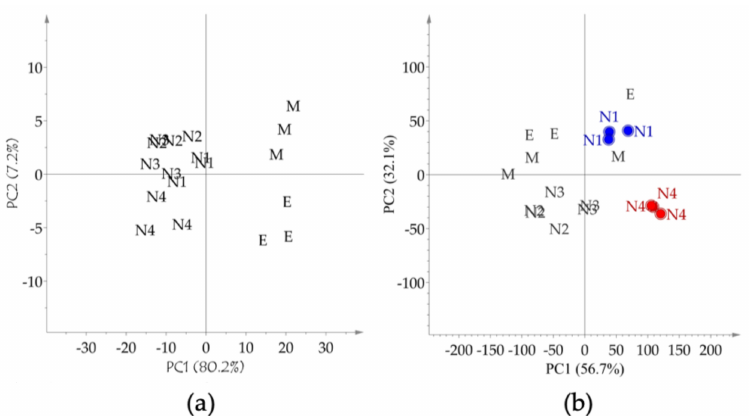
Figure 3. Score plot of principle component analysis of the HPTLC ( a ) and HPLC ( b ) data obtained from the extracts of 80% aqueous methanol, 70% aqueous ethanol, and natural deep eutectic solvent (NADES) extracts of Scutellaria baicalensis bark. M: 80% methanol in water extract ( v / v ), E: 70% ethanol in water ( v / v ), N1–N4: NADES with the addition of 10% water ( w / w ). N1: citric acid– β -alanine (1:1, mole / mole). N2: citric acid–glucose (1:1, mole / mole). N3: citric acid–xylitol (1:1, mole / mole). N4: